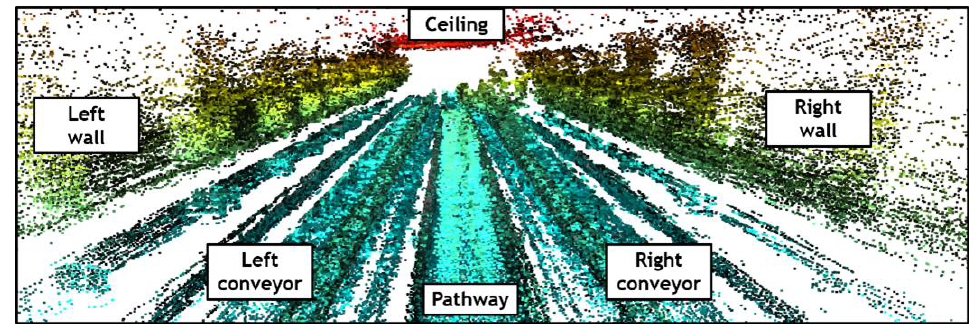
Figure 5. Cloud point map view of the area of the experiment.